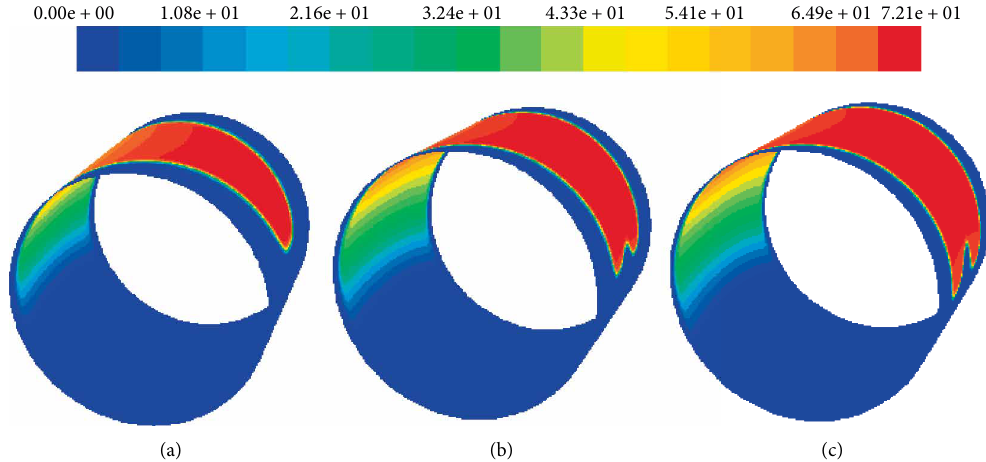
= 2000 r/min. (b) = 4000 r/min. 𝑛 𝑛